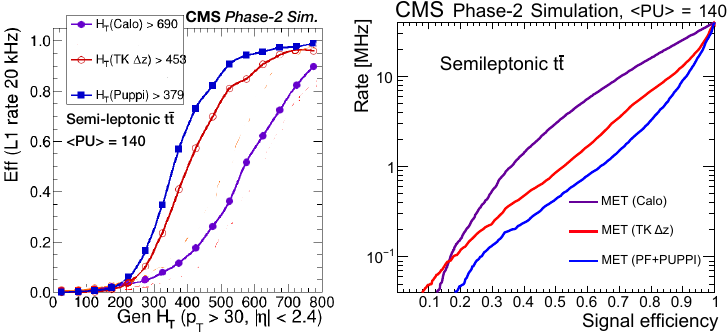
Figure 2. Left: turn-on for prototype H T triggers using calorimeters, tracks and PF + PUPPI objects, for thresholds corresponding to a Level-1 rate of 20 kHz. Right: Level-1 Rate as function of signal e ffi ciency for prototype p miss triggers using calorimeters, tracks and PF + PUPPI T